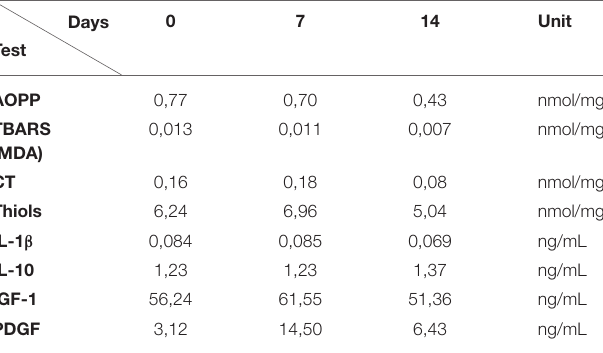
TABLE 2 | Obtained data from analysis of blood plasma markers related to inflammation and tendon healing